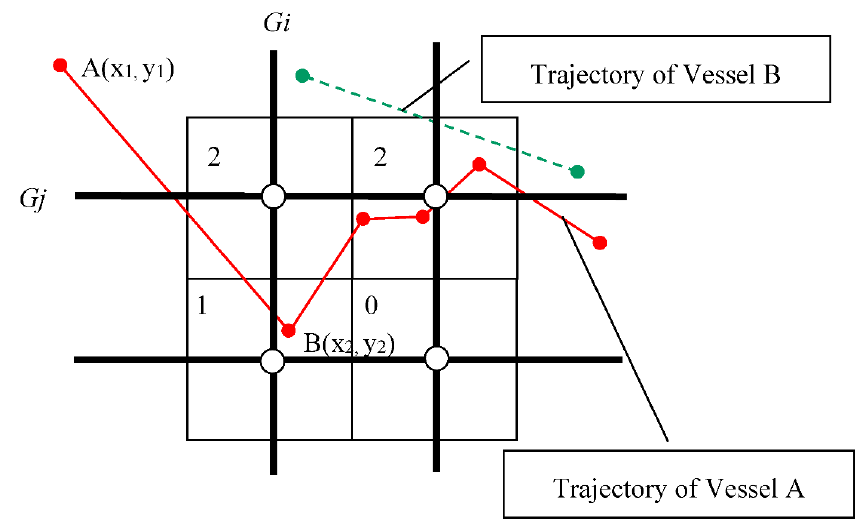
Figure 3. Geometric interpretation of the method for determining the value of a mesh in a GRID